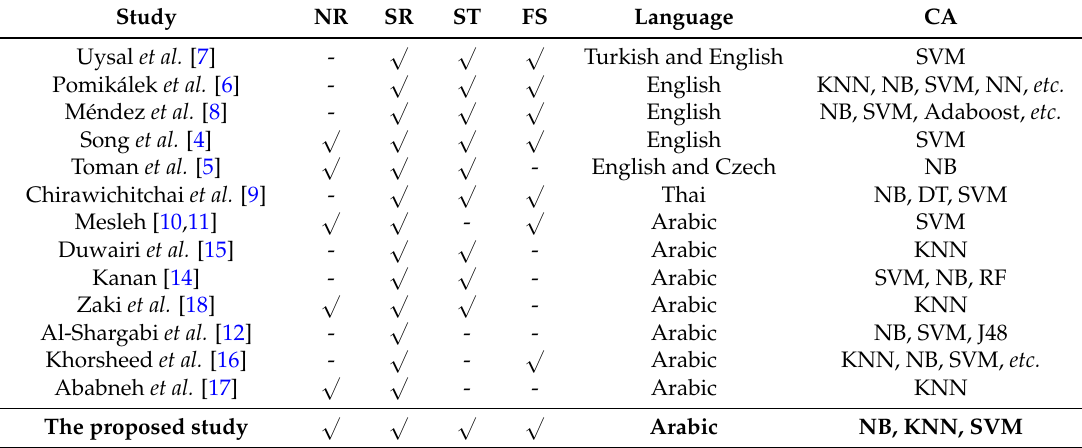
Table 1. Comparison of the characteristics of this study with those of the previous studies. Study NR SR ST FS Language